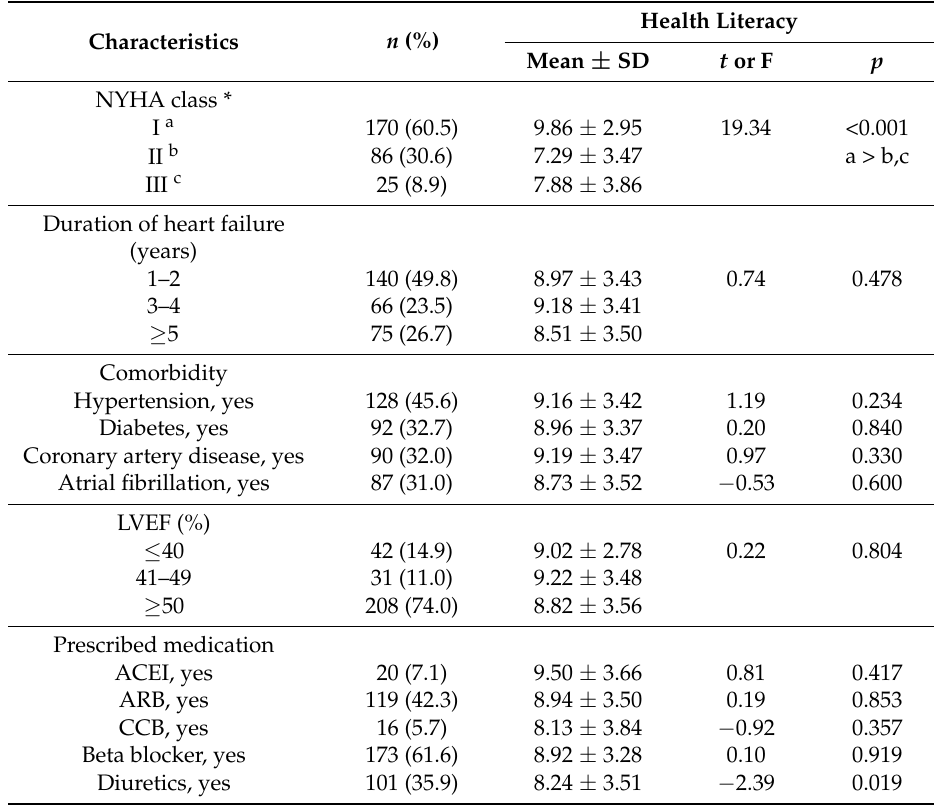
Table 2. Patients’ clinical characteristics and differences in health literacy ( n =